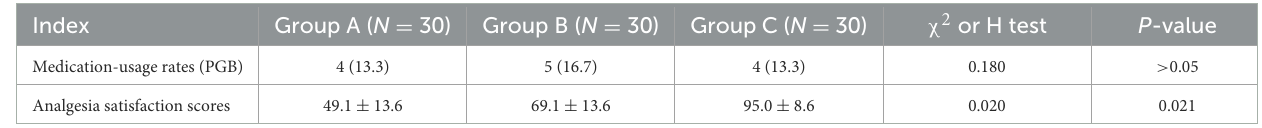
TABLE 7 The number of patients using analgesics and patient satisfaction after